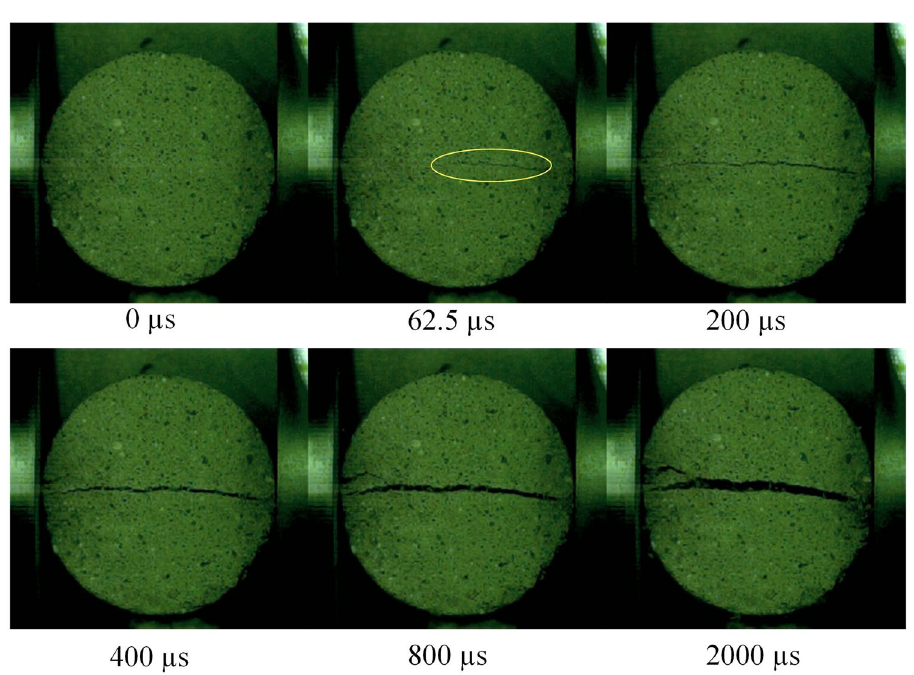
Figure 11. High speed camera snapshots during the failure process of mortar BD specimen